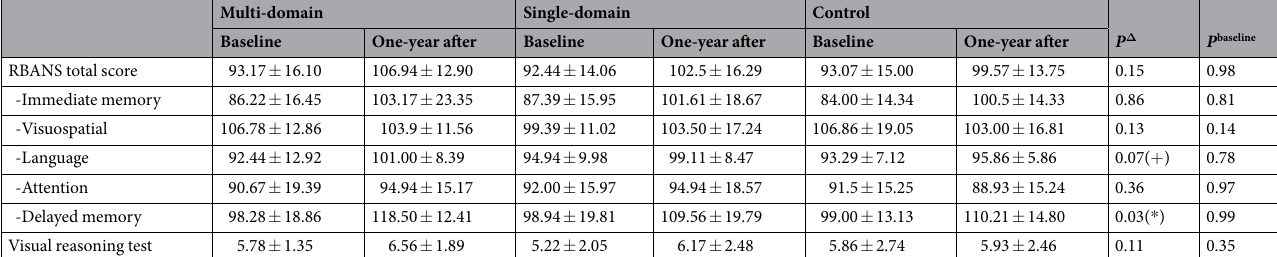
Table 2. The RBANS total score and sub-category scores (mean ± SD) of the older adult participants at baseline and one year after training. P Δ : One-way ANOVAs across groups with differences between one year after training and baseline (before training) in cognitive measures as dependent variables, and scores of the psychological measures at baseline, age, gender, and education years as covariates. P baseline : One-way ANOVAs across groups with scores of the measures at baseline as dependent variables, and age, gender, and education years as covariates. ( + p < 0.1, * p < 0.05). As a reference, in our previous larger-sample behaviour study, RBANS